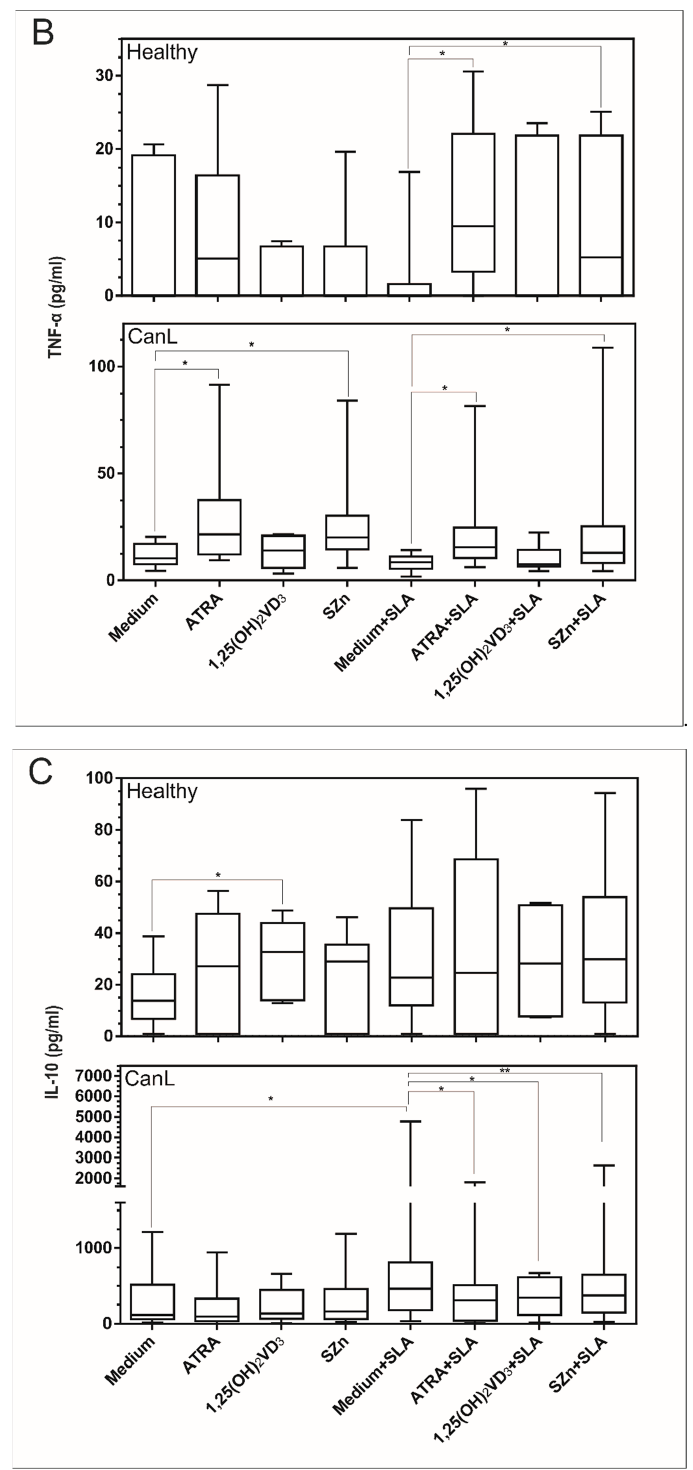
Figure 4. Cytokine production in the supernatant of spleen leukocyte cultures of the CanL group and the control group of healthy dogs supplemented with nutrients. Spleen leukocytes from the CanL ( n = 10, 7 and 15 for INF- γ , TNF- α and IL-10, respectively) and healthy dogs ( n = 5) were cultured in medium alone or with the addition of ATRA, 1,25(OH) 2 VD 3 and SZn, with and without SLA. After 72 h, IFN- γ ( A ), TNF- α ( B ) and IL-10 ( C ) production in the culture supernatant was determined by ELISA. Bars represent the median and IQR with minimum and maximum error bars. Asterisks indicate a significant difference for the comparisons within the treatment (Wilcoxon test, * p < 0.05 and ** p < 0.01). TNF- α was significantly increased in the culture supernatant of the spleen leukocytes stimulated with ATRA and SZn in the CanL and control groups in the presence of SLA (Figure 4B), but in the absence of SLA, only the CanL group exhibited this effect. No effect was observed with the remaining treatment conditions or for the stimulation with 1,25(OH) 2 VD 3 (Figure 4B). IL-10 was significantly increased in the medium alone when compared to the me- dium and SLA (Figure 4B), and it was reduced in the culture supernatant of the spleen leukocytes stimulated with ATRA, 1,25(OH) 2 VD 3 , and SZn in the CanL group in the pres- ence of SLA, while no effect was observed in the absence of SLA. In the control group, IL- 10 production was increased in the spleen leukocytes only after the addition of 1,25(OH) 2 VD 3 . No effect was observed for the remaining treatment conditions (Figure 4C). 3.4. In Vitro Supplementation of Spleen Leukocytes in the CanL Group Stimulated with 1,25(OH) 2 VD 3 and SZn Reduced the Parasite Load, but after the Stimulation with SLA, No Effect Was Observed Intracellular Zn can influence the phagocytosis and microbicidal activity [24]. On this basis, we determined whether the supplementation of a spleen leukocyte culture of the CanL group with ATRA, 1,25(OH) 2 VD 3 , and SZn would affect the parasite load. The